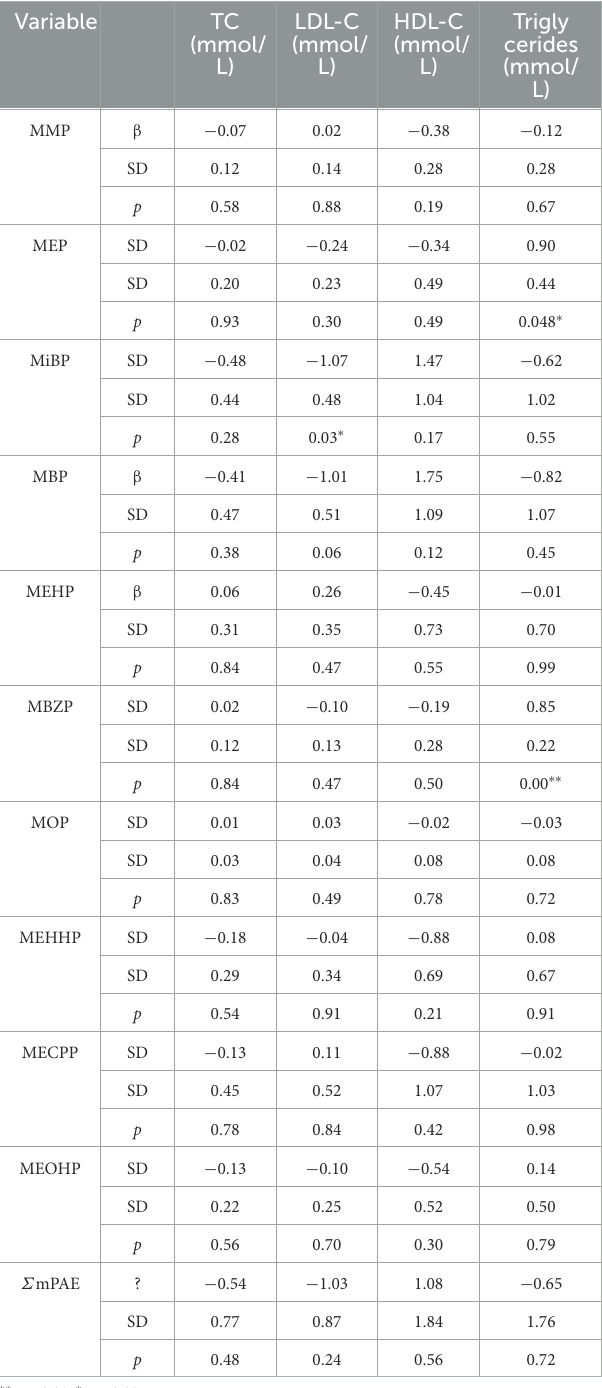
TABLE 3 Associations between mPAEs concentrations with lipid levels.